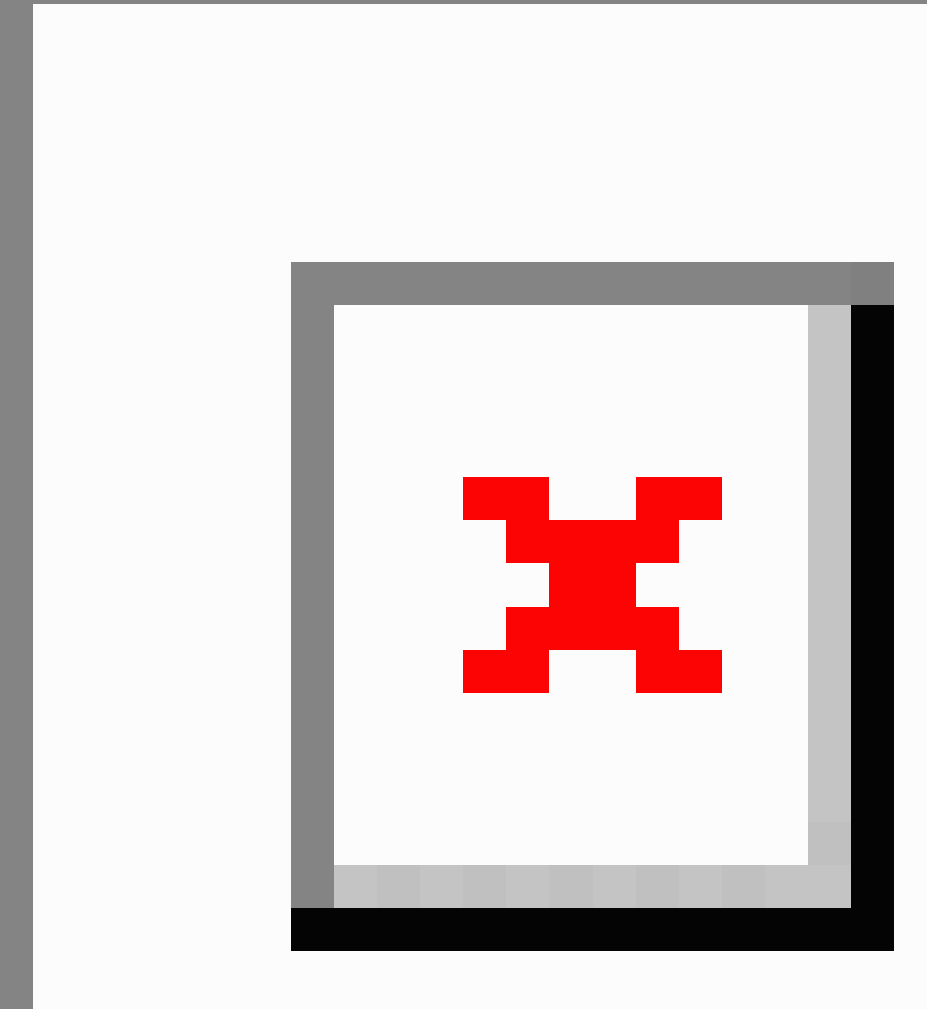
Figure 2. Distribution of scores: